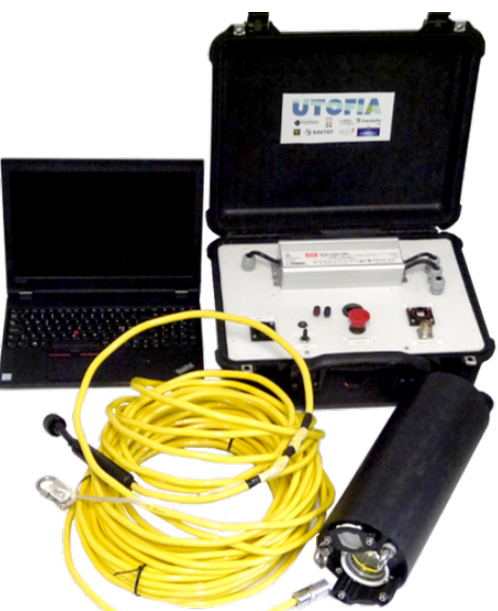
Figure 3. Range-gated 3D camera system. The full system includes a top-side box, Gigabit Ethernet cable, PC, and a cylindrical underwater